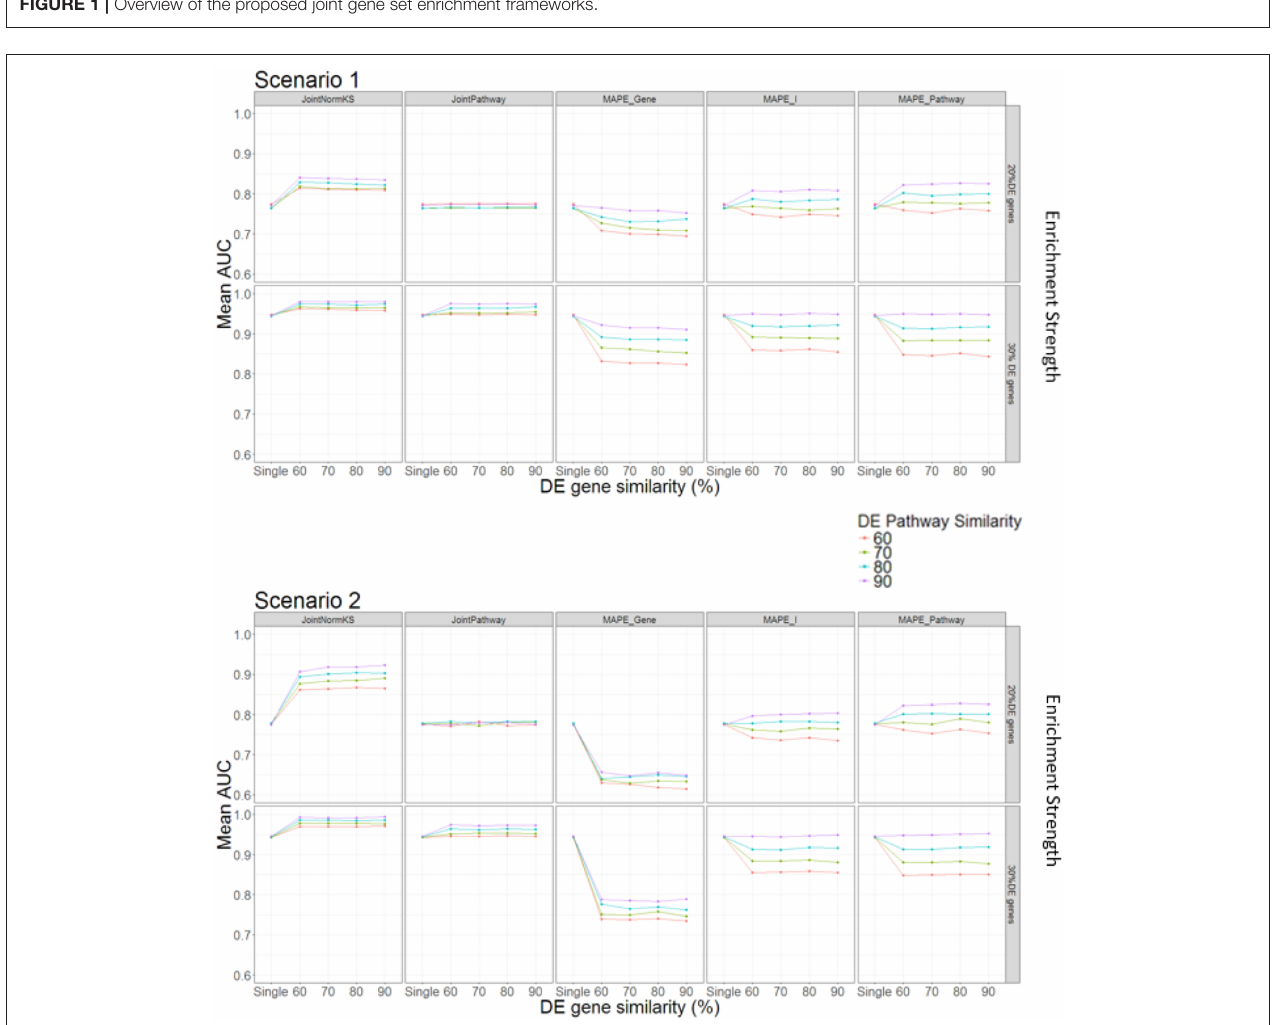
FIGURE 2 | AUC comparison among different methods under different parameter